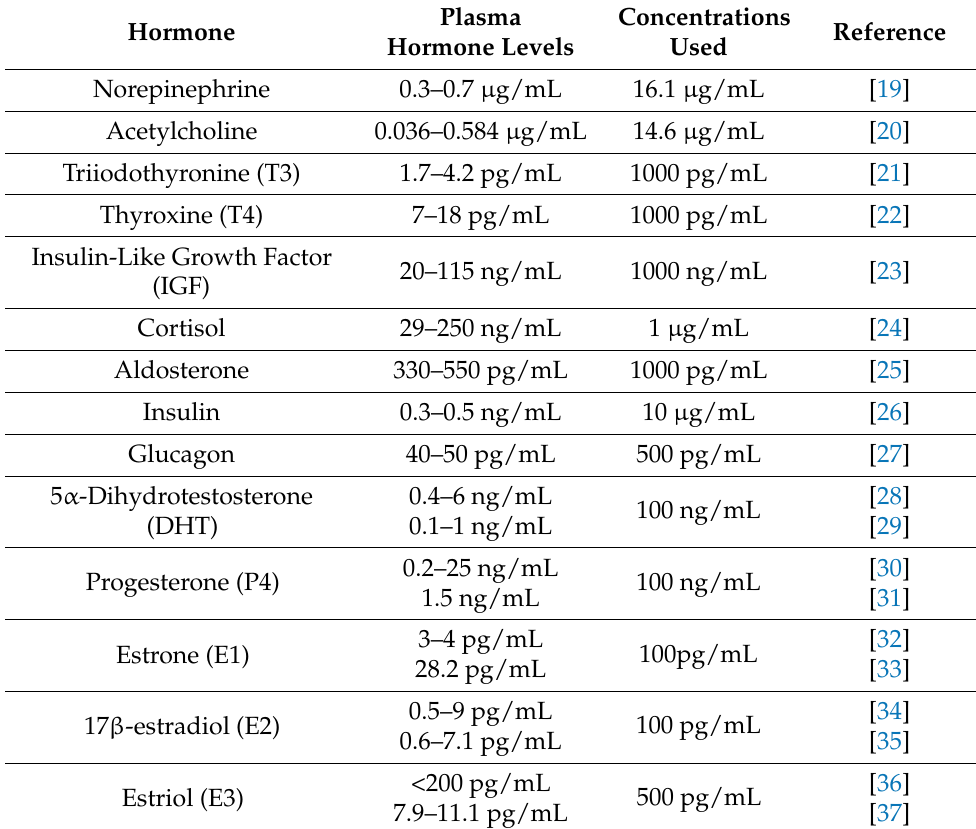
Table 1. Physiological plasma concentrations of hormones and treatment concentrations used in this